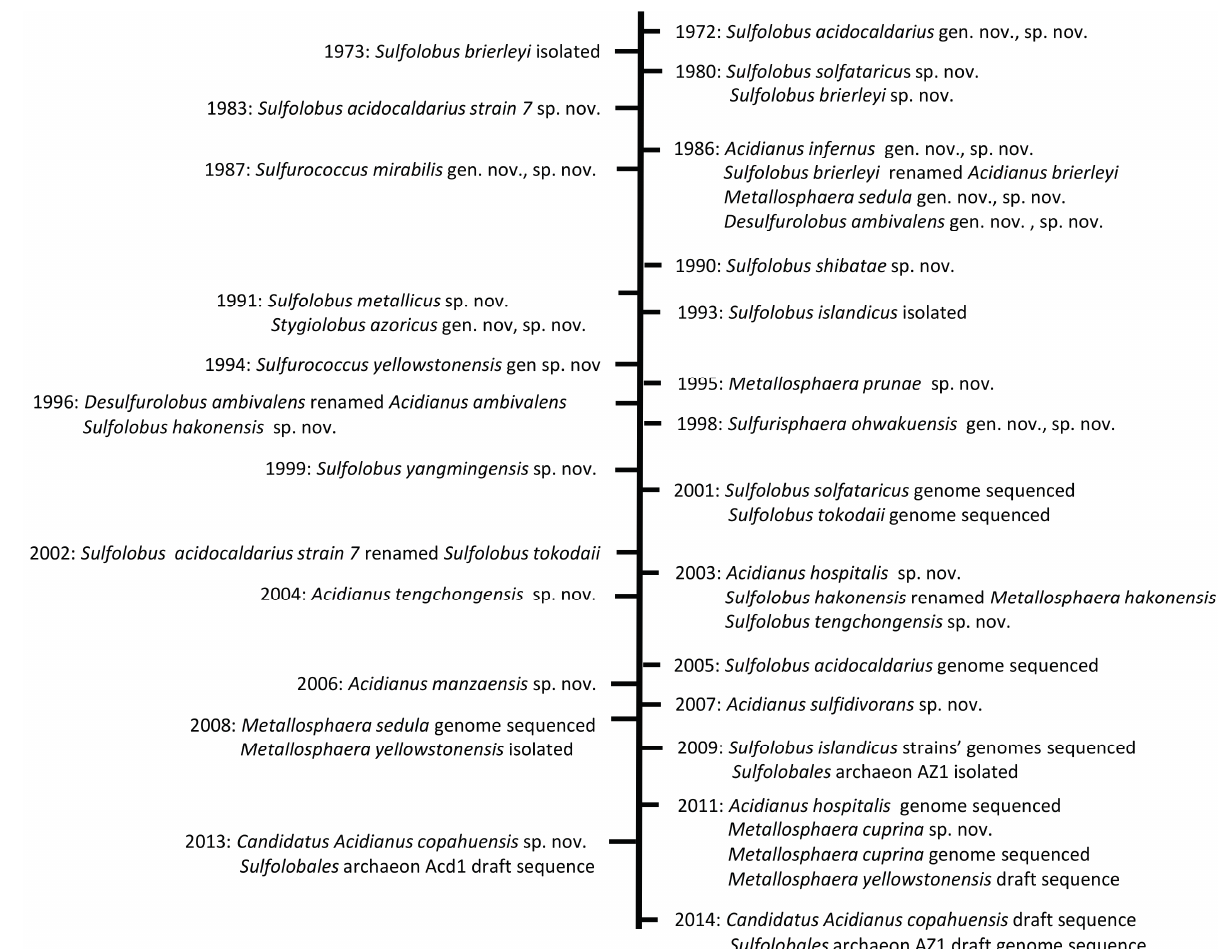
Figure 1. Chronology of microbiology advances within the Sulfolobales